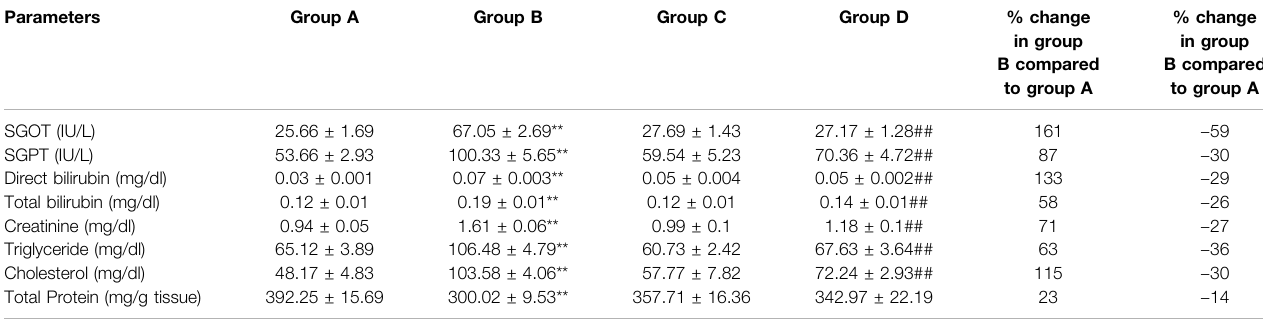
TABLE 1 | Effect of 4-(methylthio)butyl isothiocyanate on hepatic, renal, and lipid pro fi le in control and experimental group of animals. SGOT: Serum glutamic oxaloacetic transaminase, SGPT: Serum glutamic pyruvic transaminase. All the values are represented as mean ± SEM for six animals. Signi fi cant levels are ** p < 0.01 when compared with group A and ## p < 0.01 when compared with group